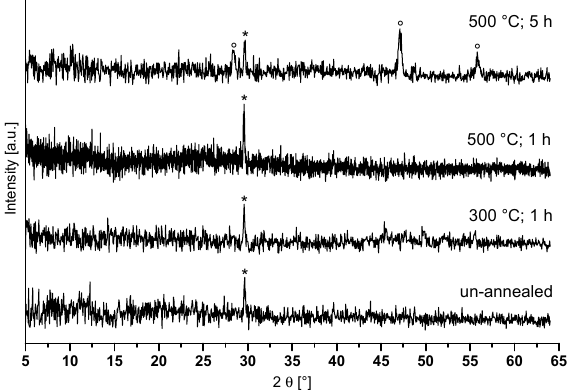
Figure 2. Powder diffractograms of CaAlF 5 xerogel in a normal crucible at different thermal treatment in a non-preheating oven (* sample holder, ° CaF 2 ).